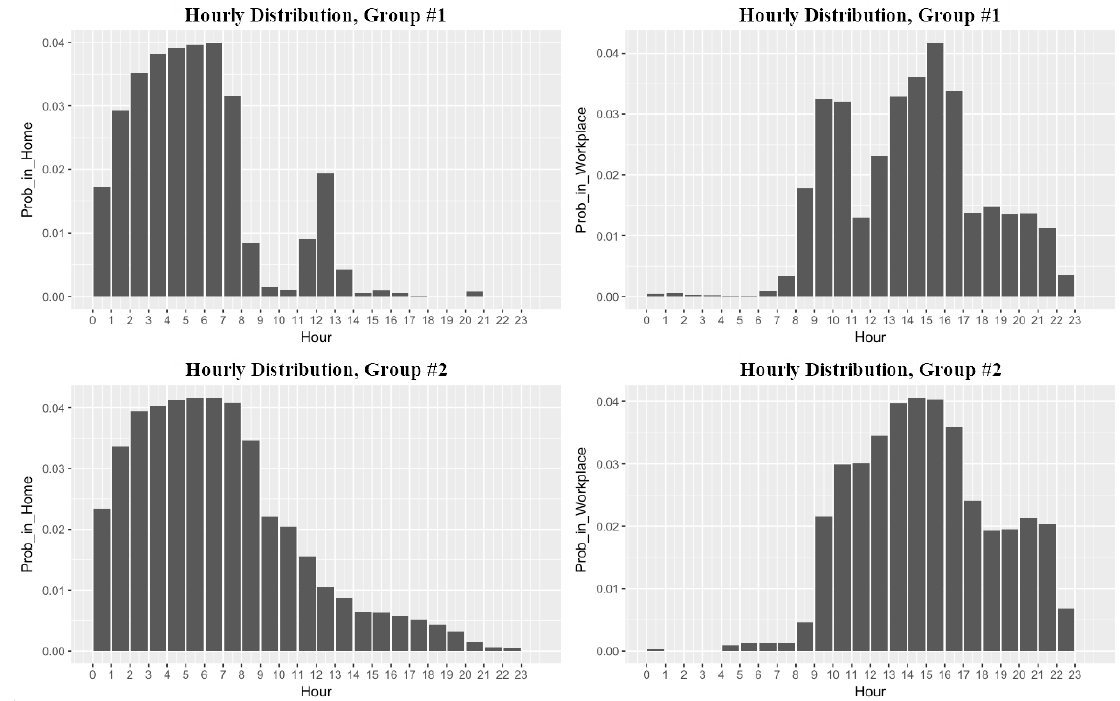
Figure 9. Temporal signatures of the visits of individuals in Groups #1 and #2 to their homes and workplaces.